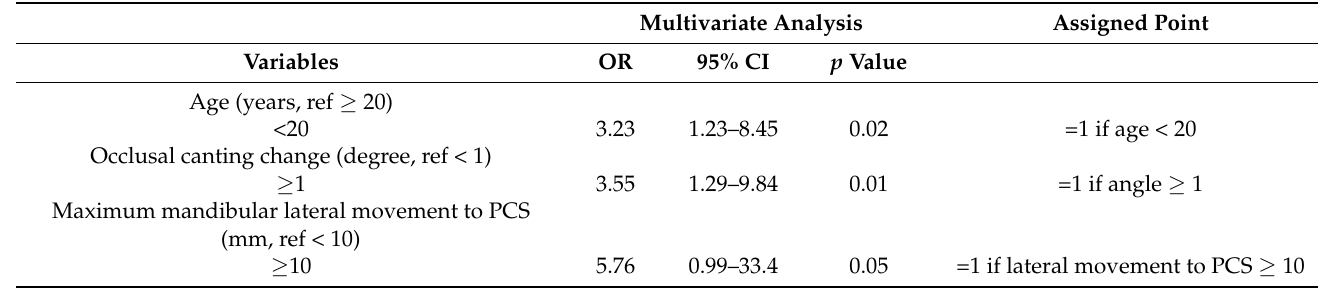
Table 3. Multivariable logistic regression analysis for clinical factors associated with PCS change.